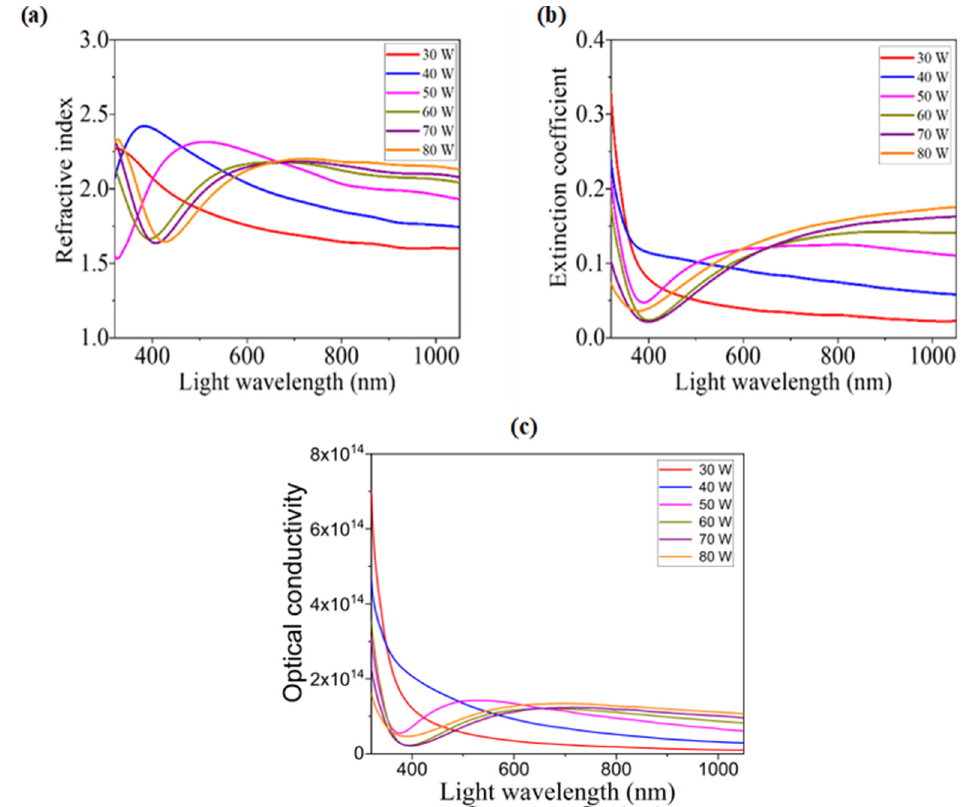
Figure 6. Variation in: ( a ) refractive index, ( b ) extinction coefficient, and ( c ) optical conductivity of different WO x films due to the light wavelength.